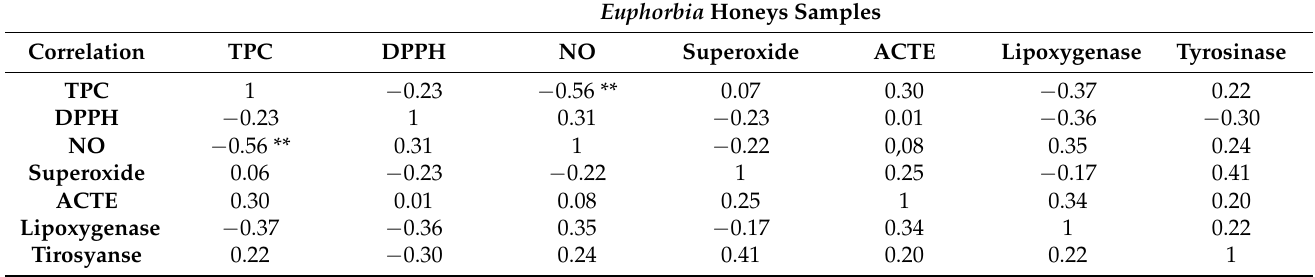
Table 9. The correlations between the results of TPC, antioxidant activities (DPPH, NO, superoxyde scavenging activities) and inhibition of acetylcholinesterase, lipoxygenase and tyrosinase activities of Euphorbia honey samples and Euphorbia honey phenolic